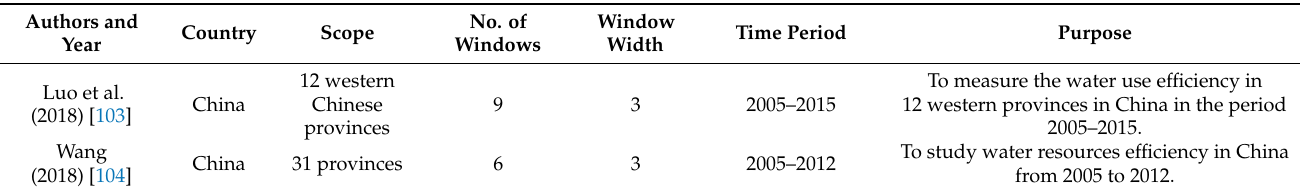
Table 16. Articles classified under the water category.